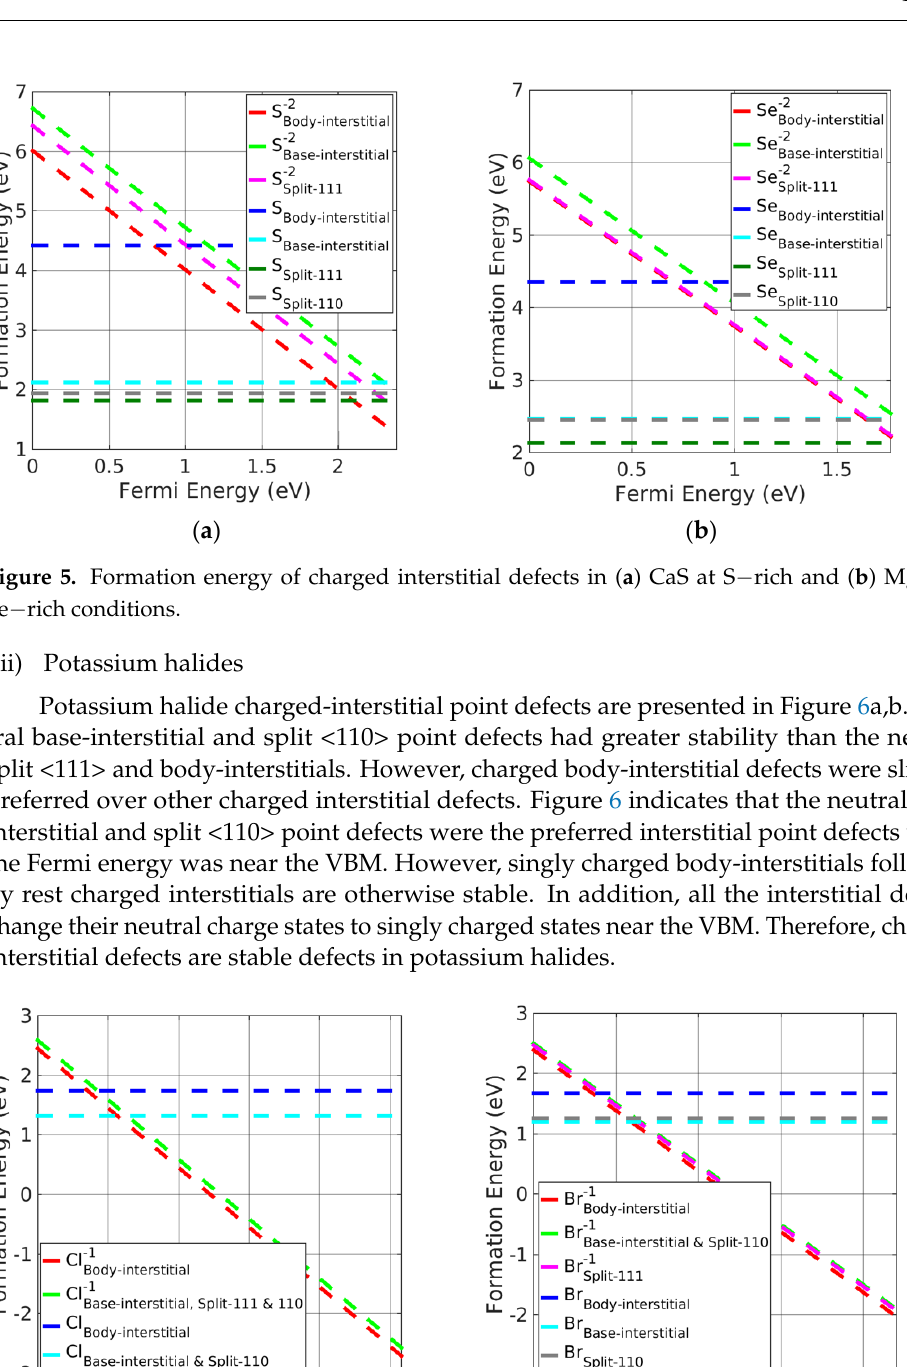
( b ) Figure 4. Formation energy of charged interstitial defects in ( a ) PbS at S − rich and ( b ) PbSe at Se − rich conditions. (ii) Alkaline-earth metal monochalcogenides As with Pb monochalcogenides, the split-interstitial defects were stable in a neutral charge state (see Figure 5a,b). Nevertheless, body-interstitial defects were stable in their